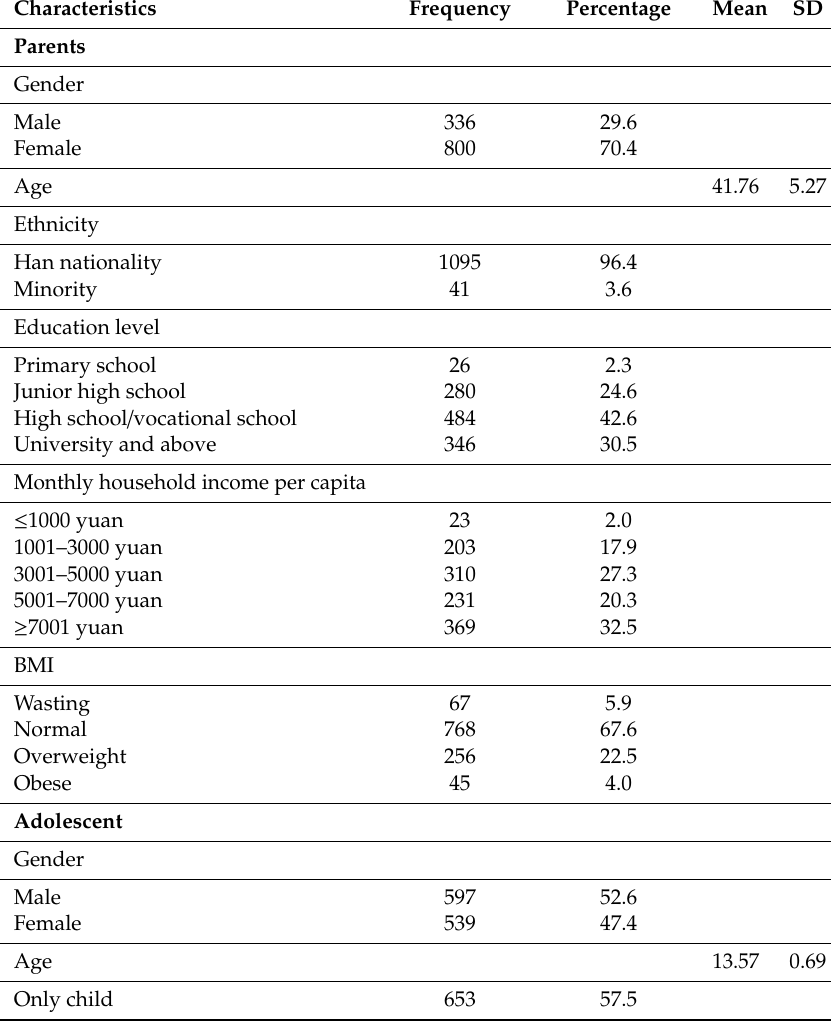
Table 1. Demographic characteristics of participants (parents and adolescent, n =